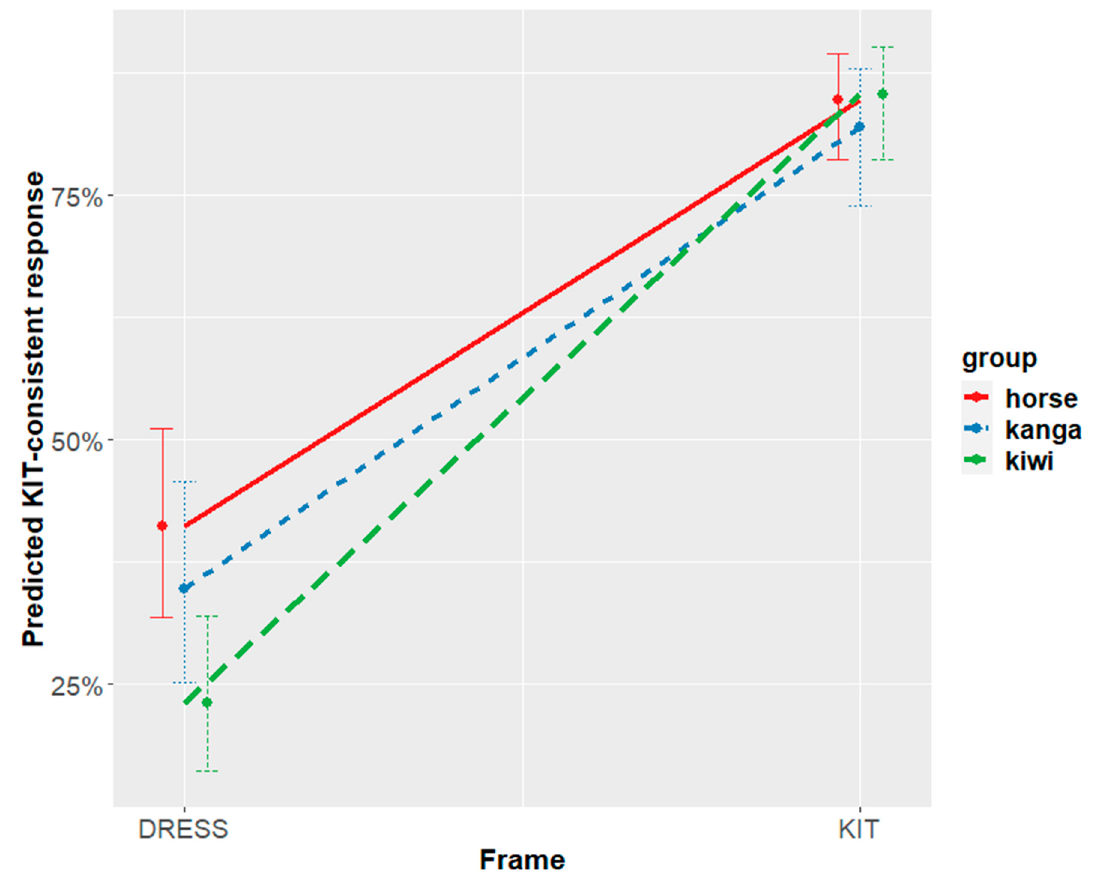
Figure 5. Model prediction plot from the model of experiment one (see Table 5).